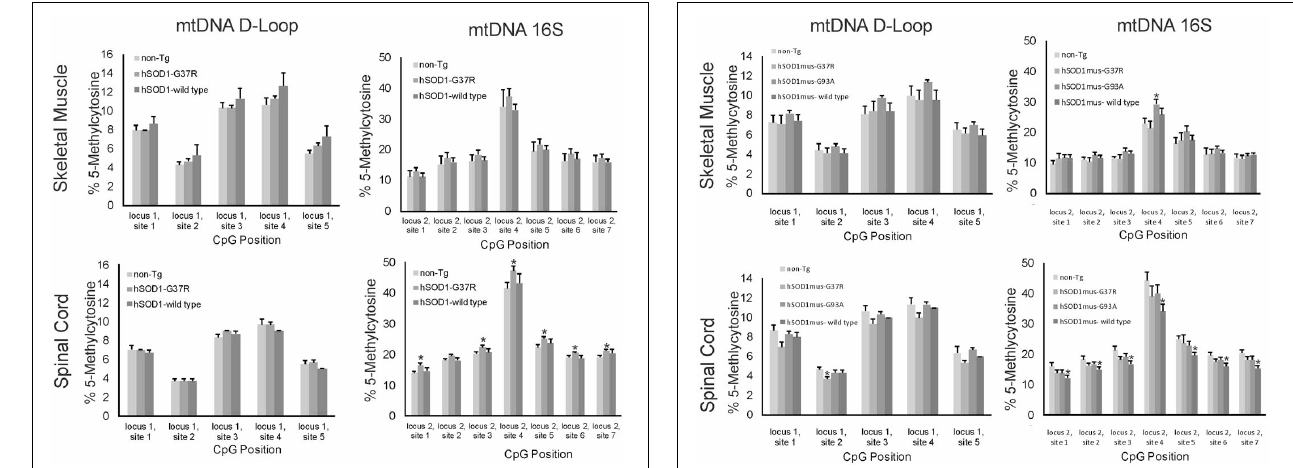
FIGURE 8 | 5-methylcytosine (5mC) content in two loci of skeletal muscle mtDNA in conditional transgenic mouse models of ALS. Graphs show the %5mC content at 5 CpG sites in the D-loop ( left ) and at 7 CpG sites in the16S rRNA gene in the skeletal muscle ( top ) and spinal cord ( bottom ) of tg mice with skeletal muscel-restricted expression of G37R, G93A, or wildtype hSOD1 variants. Tg and non-tg control mice were 16–20 months of age. Values are mean ± SEM derived from mtDNA isolated from three different mice per genotype. Asterisks denote significant differences in tg mice compared to non-tg control mice ( p < 0 .